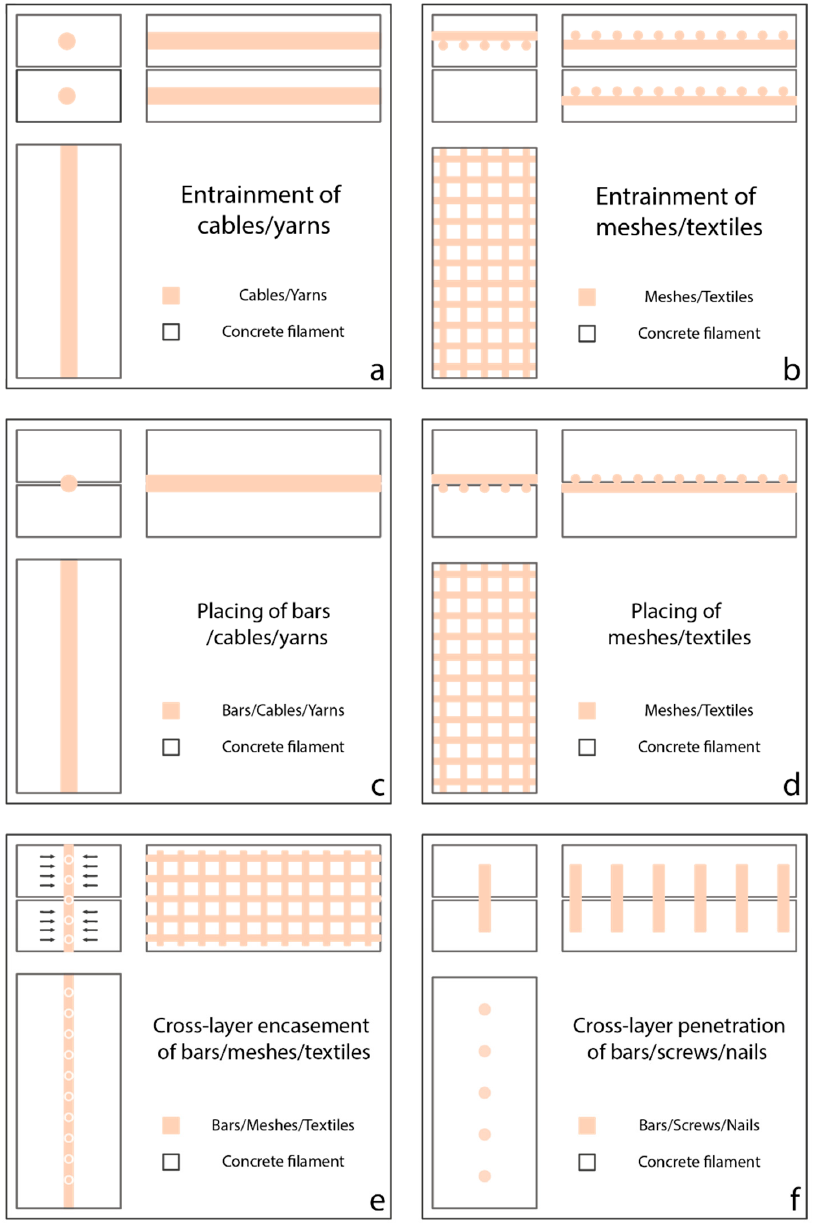
Figure 9. Cross-section view (left-top), side view (right-top) and plan view (left-bottom) of: ( a ) entrainment of cables/yarns; ( b ) entrainment of meshes/textiles; ( c ) placing of bars/cables/yarns; ( d ) placing of meshes/textiles; ( e ) cross-layer encasement of bars/meshes/textiles; and ( f ) cross-layer penetration of bars/screws/nails.